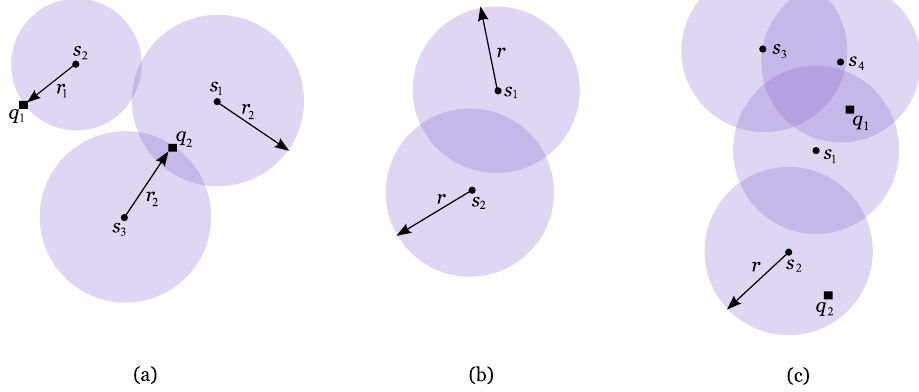
Figure 4. Set S is represented by dots. (a) Point q is covered by antenna s 1 = d ( s , q ) . Point q range r is 2 -covered by S with minimum range r 1 2 1 2 , r ) and D ( s , r ) is shown in dark purple. (c) Regions 2 -covered by S lens formed by D ( s 1 2 with range r are shown in dark purple. Point q is 2 -covered by S , whilst q 1